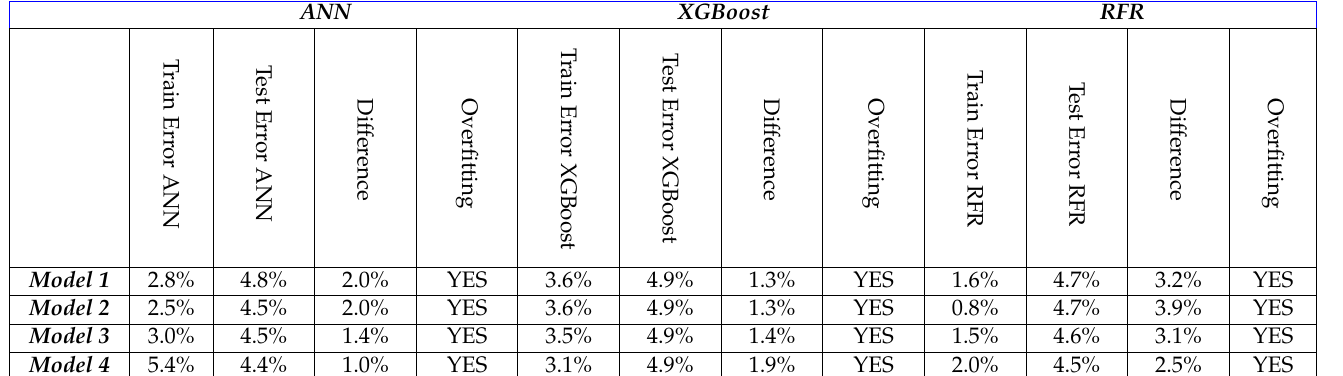
Table 14. Train and test errors of ANN, XGBoost, and RFR.